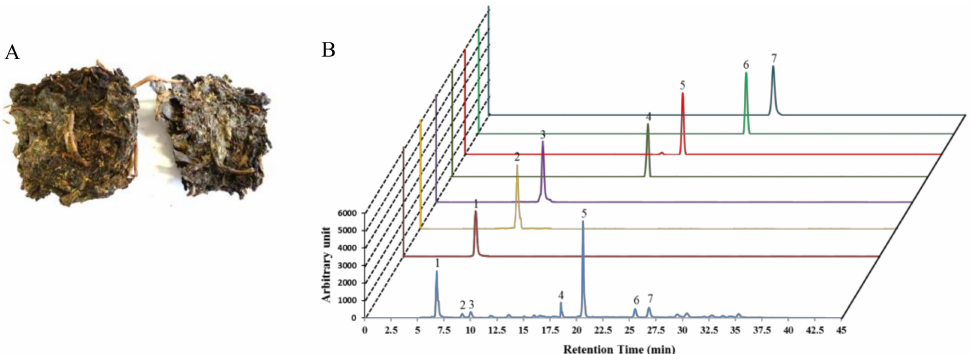
Figure 1. Fuzhuan-brick tea (FBT) ( A ) with the “golden flora” (the yellow dots) in its leaves. ( B ) High pressure liquid chromatography (HPLC) profile of Fuzhuan-brick tea aqueous extract (FBTA) with standards, including gallic acid (peak 1), theaflavins (peak 2), theobromine (peak 3), epigallocatechin (EGC) (peak 4), caffeine (peak 5), epicatechin (EC) (peak 6), and epigallocatechingallate (EGCG) (peak 7). A serving of 100 µ g/mL of FBTA solution contains ~10 µ M gallic acid, ~2 µ M theoflavins, ~2 µ M theobromine, ~4 µ M EGC, ~15 µ M caffiene, ~2 µ M EC, and ~2 µ M